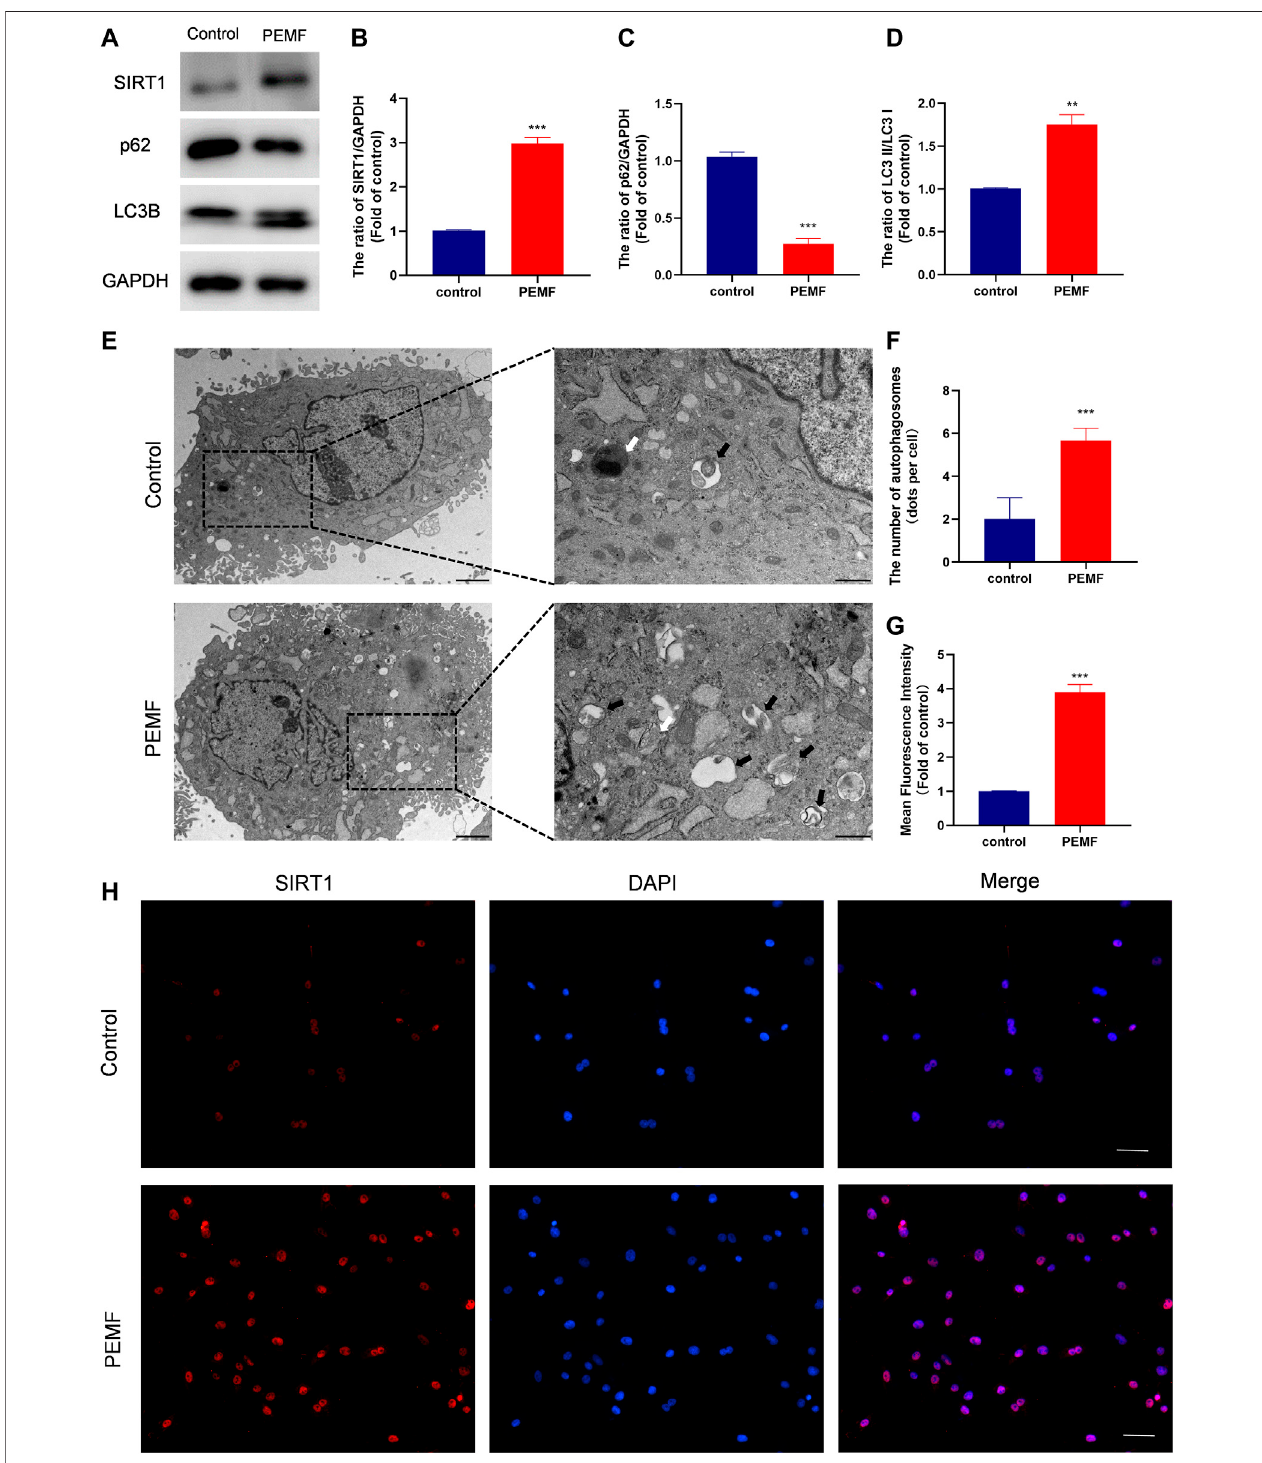
FIGURE 3 | PEMF exposure promotes autophagy and elevates SIRT1 levels and activity in the human degenerated NP cells. (A – D) Western blot and semi- quantitativeanalyses ofSIRT1,p62,and LC3Bprotein levels(n=3). (E – F) Autophagosomes andautophagolysosomes,visualizedbytransmissionelectron microscopy (Blackarrow,autophagosome;Whitearrow,autophagolysosome,scalebar:2 μ m,0.5 μ m). (G – H) Representativeimagesofimmuno fl uorescenceandsemi-quantitative analyses of SIRT1 fl uorescence intensity in NP cells, imaged by fl uorescence microscopy (scale bar = 50 μ m). ** p < 0.01, *** p < 0.001. Data presented as means ± SD.